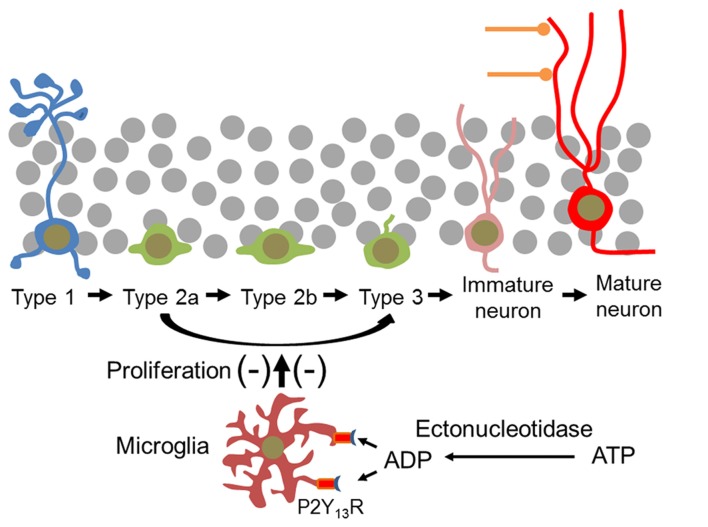
Microglial P2Y13Rs impair proliferation of neural progenitor cells and thus new neuron formation in the mouse DG. Type 1 cells are not affected. It is assumed that the effect of microglia is mediated by the P2Y13R- and ADP-induced release of extracellular signal molecules. In the hippocampal neurogenic niche the P2Y13R agonist ADP can be derived from extracellular ATP by ectonucleotidases which are associated with microglia itself and with type 1 cells and neural progenitor cells (Braun et al., 2000; Shukla et al., 2005).